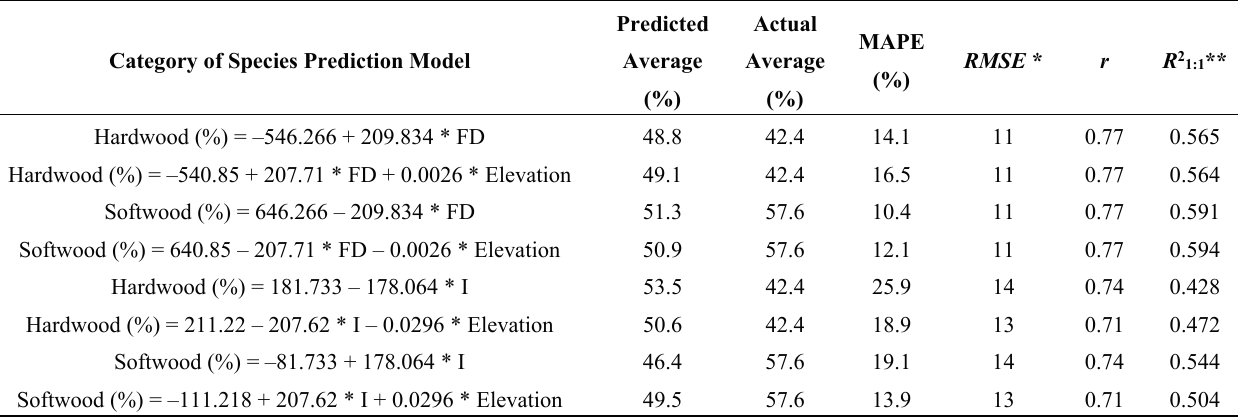
Table 9. Categories of Species Prediction Models’ Performance Evaluation Measures (Using the Predicted and Actual Values of All